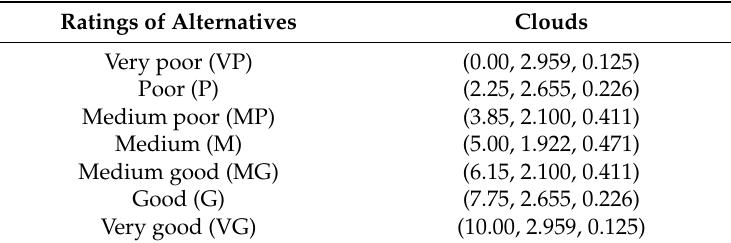
Table 3. Linguistic variables and their corresponding clouds.